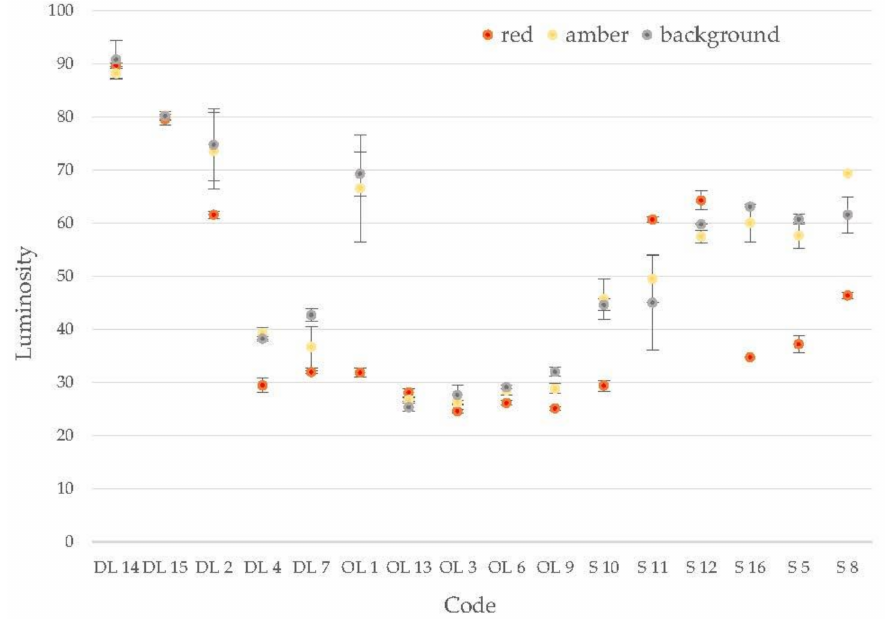
Figure 7. Average of luminosity per color for all the